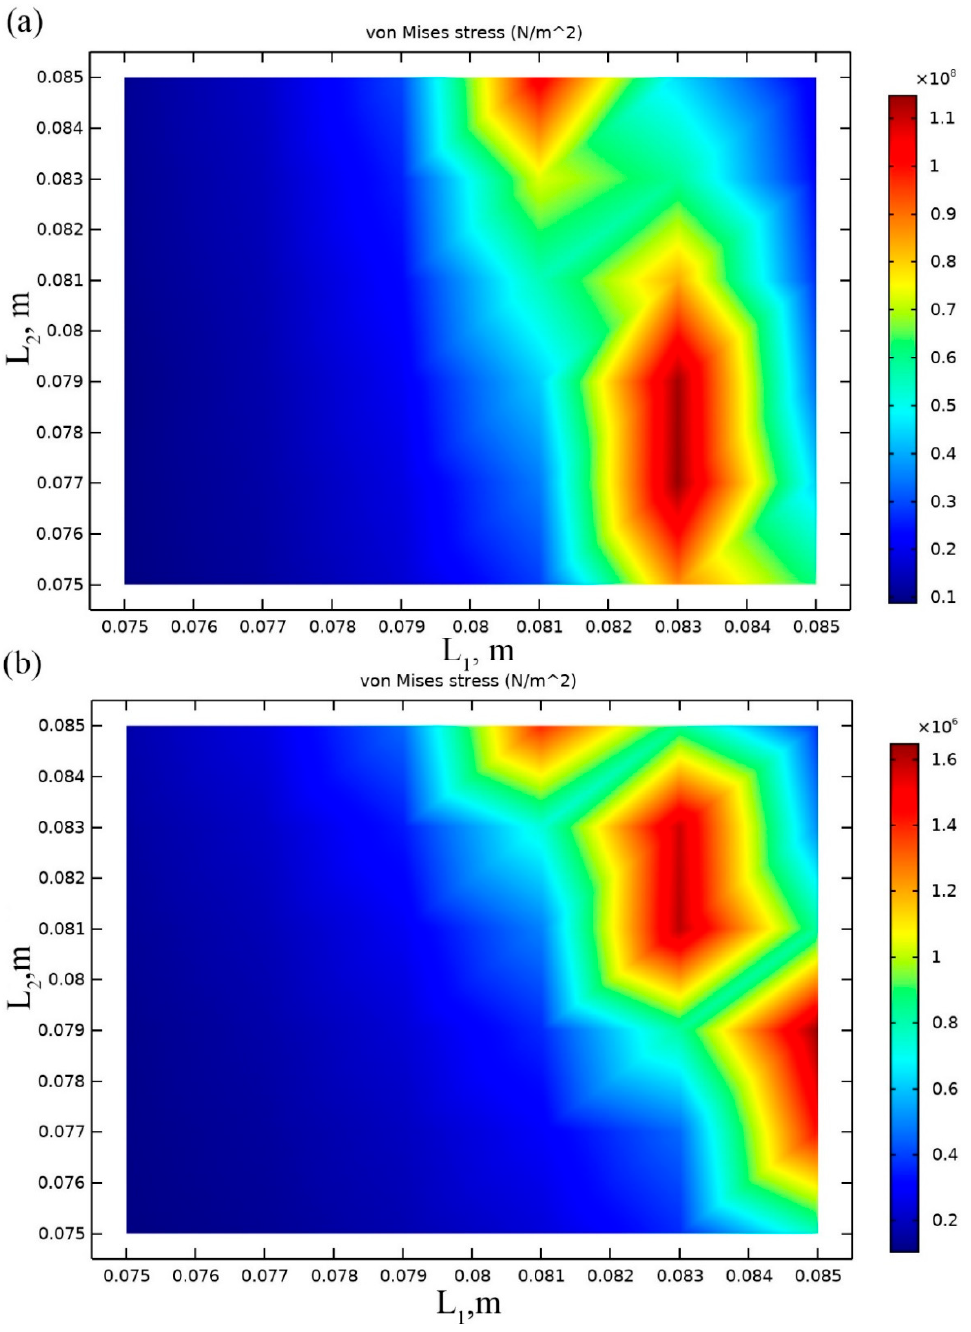
Figure 3. Plot of von Mises stresses at the resonance frequency when different L 1 and L 2 values are used: acceleration aligned to z direction, resonant frequency 24 Hz ( a ); acceleration aligned to y direction, resonant frequency 33 Hz ( b ).